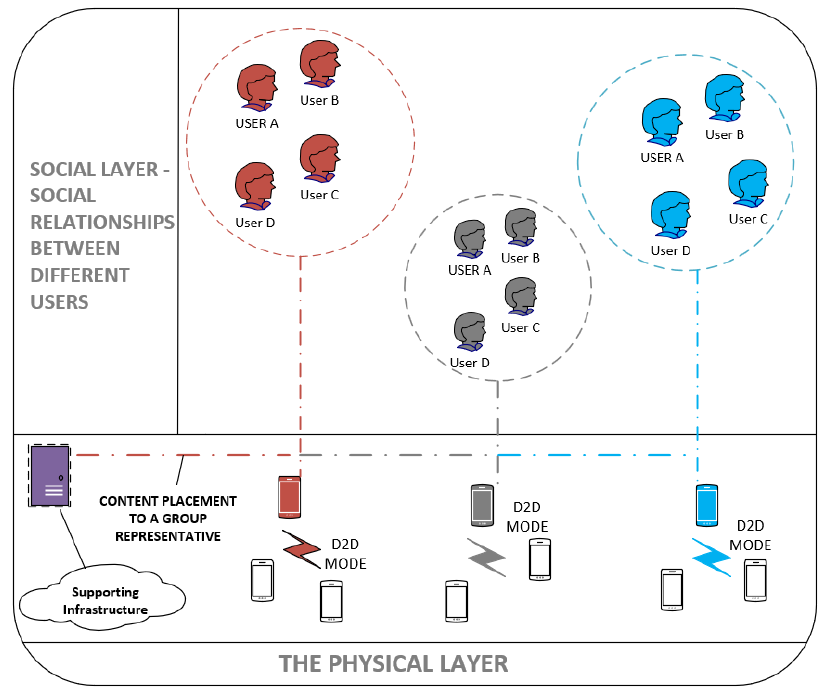
Figure 3. The visualization of a layered network showing the interaction between the social users and the corresponding physical layer.